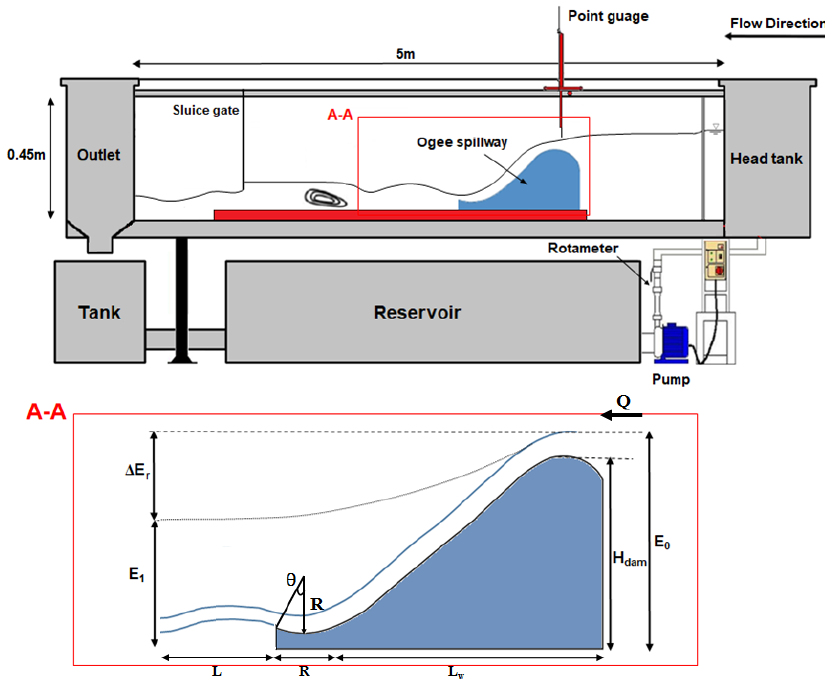
Figure 1. Schematic of the experimental setup with an ogee spillway.